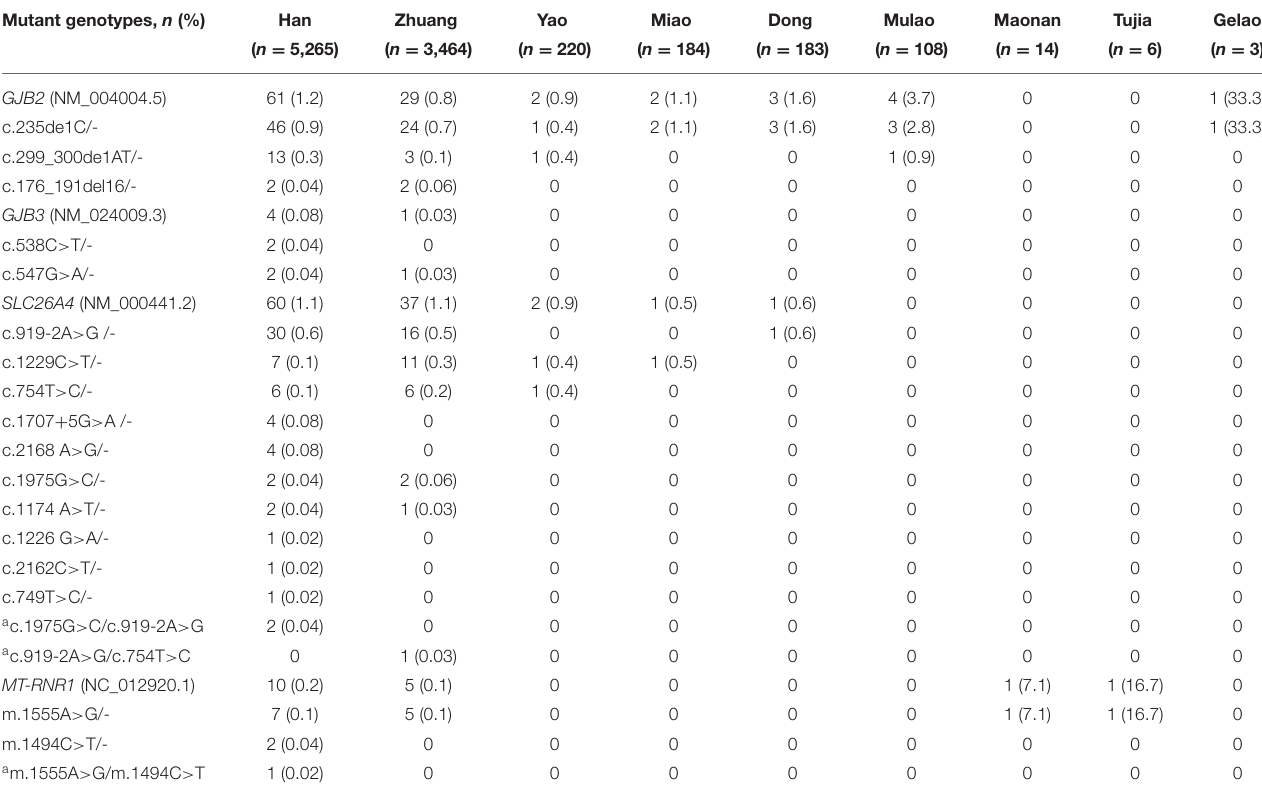
TABLE 3 | Distribution of hearing loss associated mutations in different ethnic groups. Mutant genotypes, n